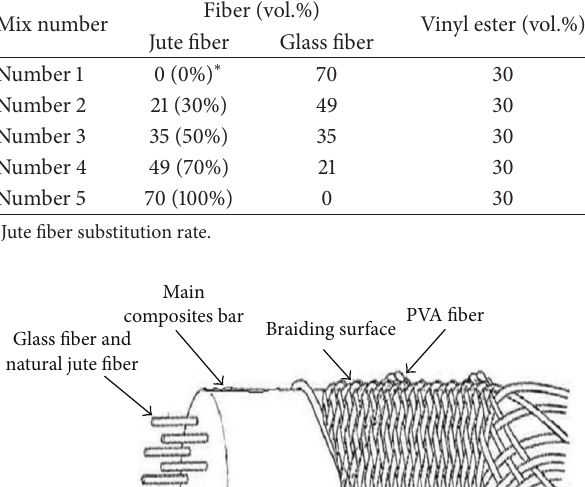
Table 1: Mechanical properties of fiber and matrix resin. Vinyl ester Mechanical properties resin